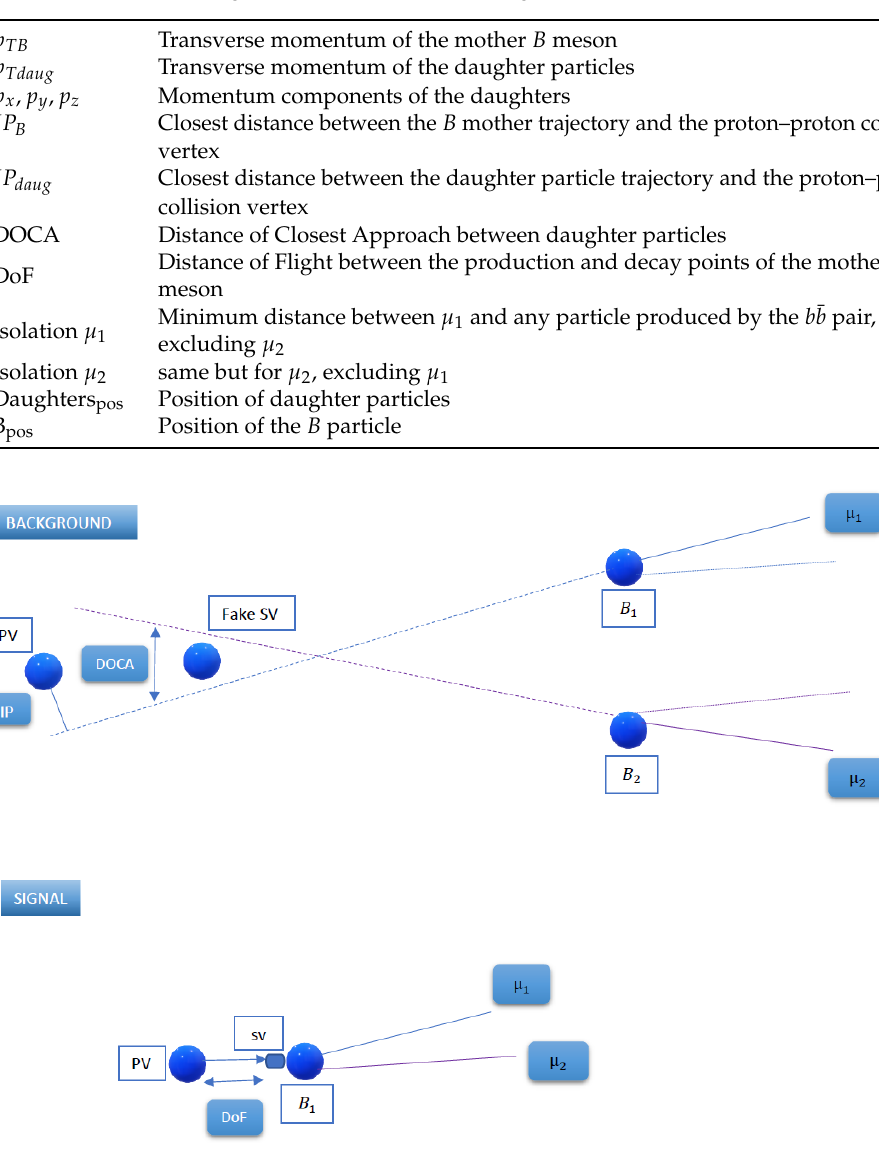
Table 2. List of features used to build the classifiers. For a mathematical definition of quantities such as the DOCA or IP see, e.g., Ref. [43]. More details are given in the text.